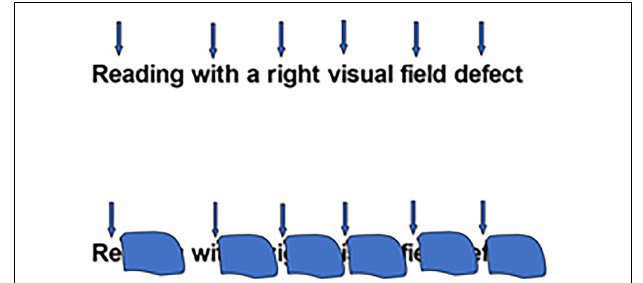
FIGURE 1 | Reading with a right sided visual field defect. Above: Upper arrows denote the position of the fovea with respect to the word when reading. Below: position of the right scotoma overlying the word when